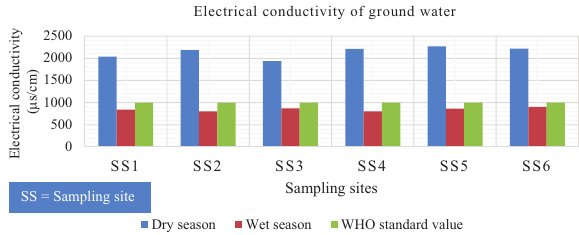
Figure 3 . Seasonal variation in Electrical conductivity of groundwater quality in the study area